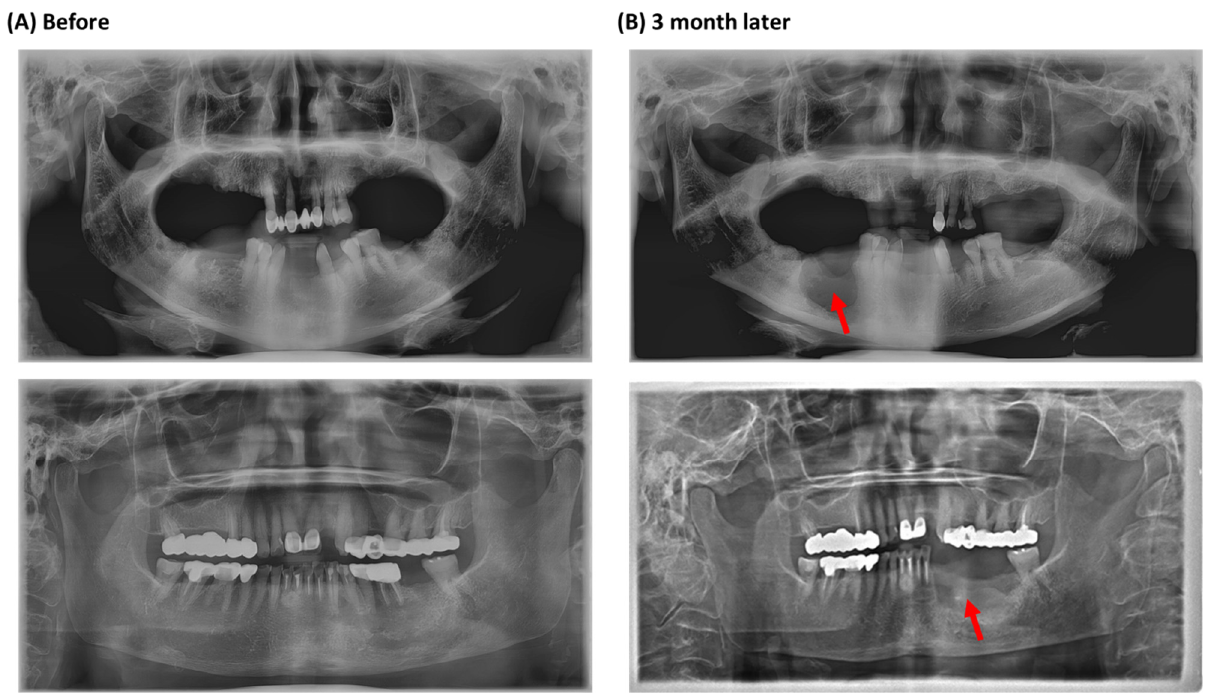
Figure 1. Panoramic radiographic images of MRONJ patients in this study. ( A ) Extraction of the mandibular molars. ( B ) Three months after the extraction. Red arrows point to the necrotic area. The incidence of MRONJ is relatively lower in the oral bisphosphonate group for osteoporosis than in the intravenous bisphosphonate group for cancer; hence, to